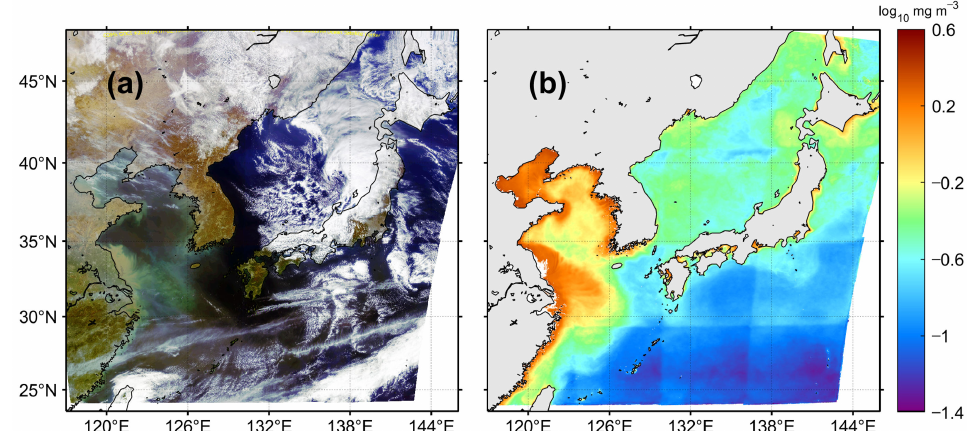
Figure 1. ( a ) Full disk red-green-blue (RGB) image of the Geostationary Ocean Color Imager (GOCI) acquired on 1 April 2012 and ( b ) monthly climatology of chlorophyll- a concentration in